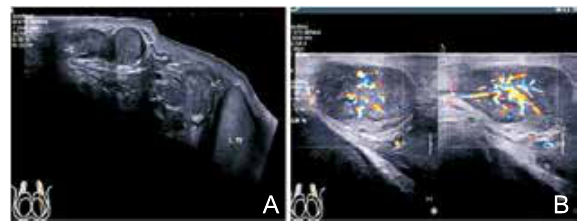
Figure 3 Type III tumor-like of lesion in Kimura disease in left spermatic cord and scrotum (A), with abundant tree branch - like blood flow